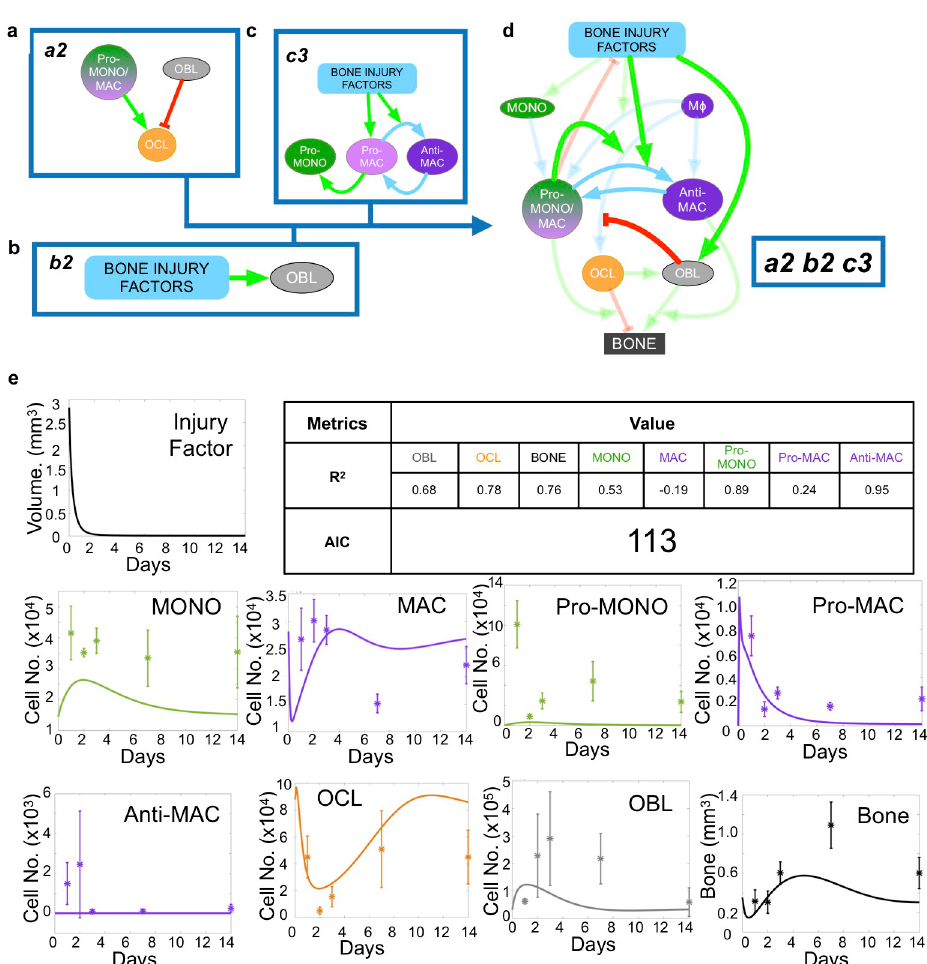
Fig 4. Other hypotheses combinations fail to recapitulate in vivo data. The example of the worst fitting hypothesis a2-b2-c1 fails to recapitulate in vivo data. a mechanism a2 assumes that pro-inflammatory monocytes/macrophages and osteoblasts promote and inhibit osteoclast formation, respectively. b mechanism b2 assumes that injury factors promote osteoblast expansion. c mechanism c1 assumes that injury factors promote pro-inflammatory monocytes/ macrophages and anti-inflammatory macrophages polarization. Anti-inflammatory macrophages drive depolarization of monocytes/macrophages back to the naive state. d schematic representation of the model using a2-b2-c1 hypothesis combination. Arrows represent positive (green) or negative (red) types of cellular interactions. e temporal plots and corresponding goodness of fit metrics (AIC and R2s) across all populations, obtained through J 1